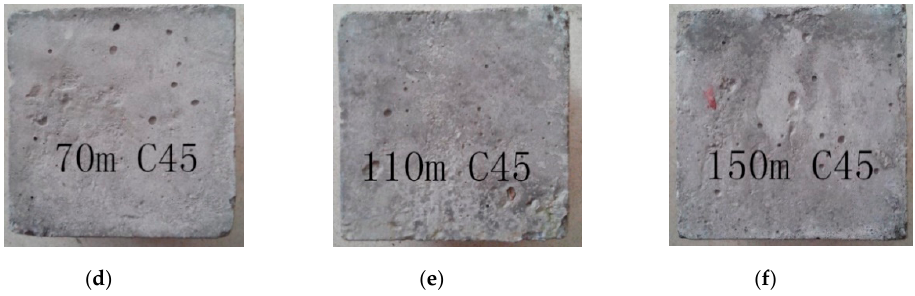
Figure 5. Photographs of specimens placed in different locations in the cooling tower. ( a ) Tower middle (300 d); ( b ) tower throat (300 d); ( c ) tower outlet (300 d); ( d ) tower middle (510 d); ( e ) tower throat (510 d); ( f ) tower outlet (510 d).